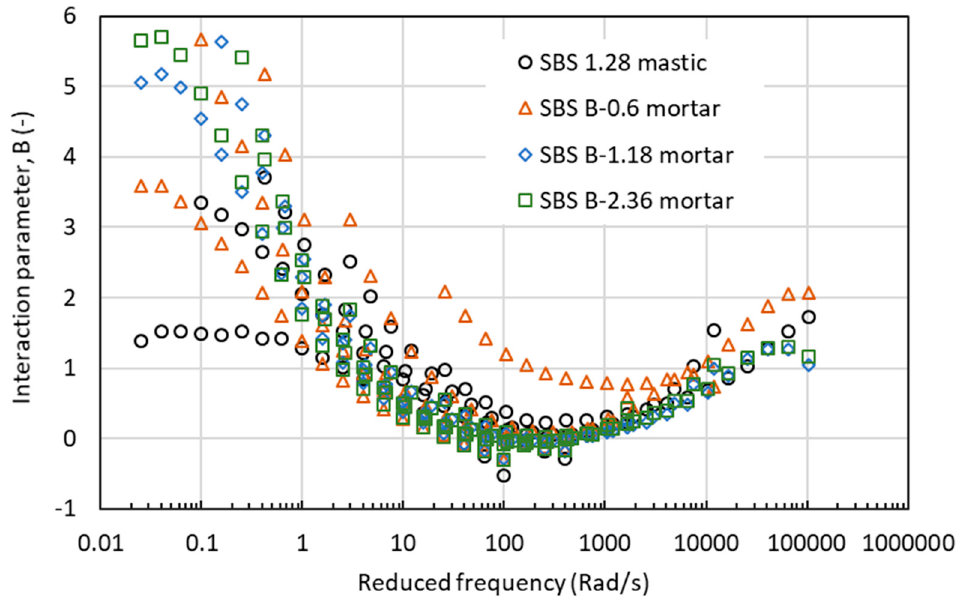
Figure 14. Interaction parameter of B values for asphalt mastic and mortar based on AC ‐ 13 mixture.